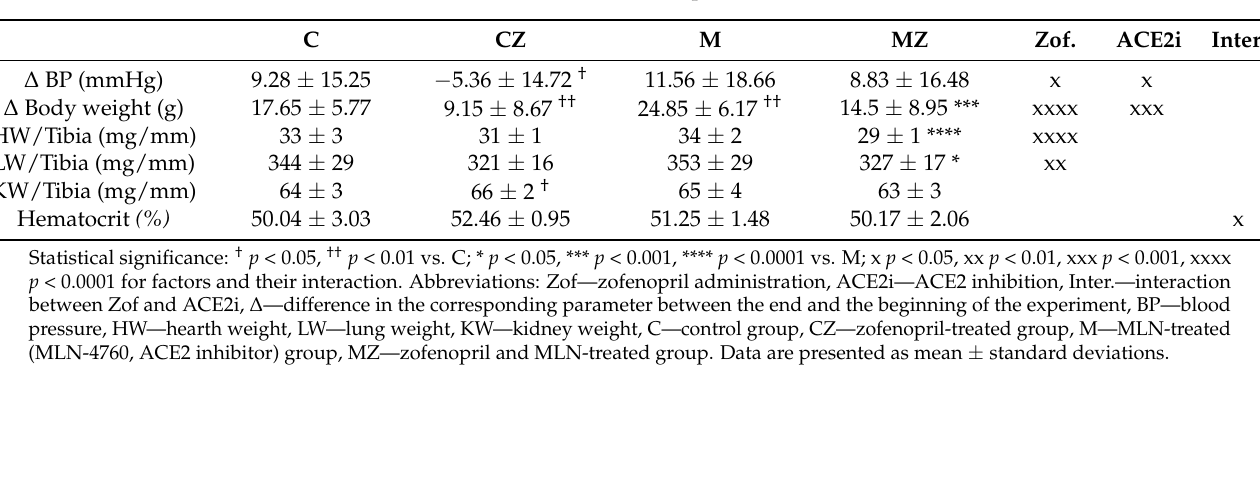
Table 1. Basic biometric